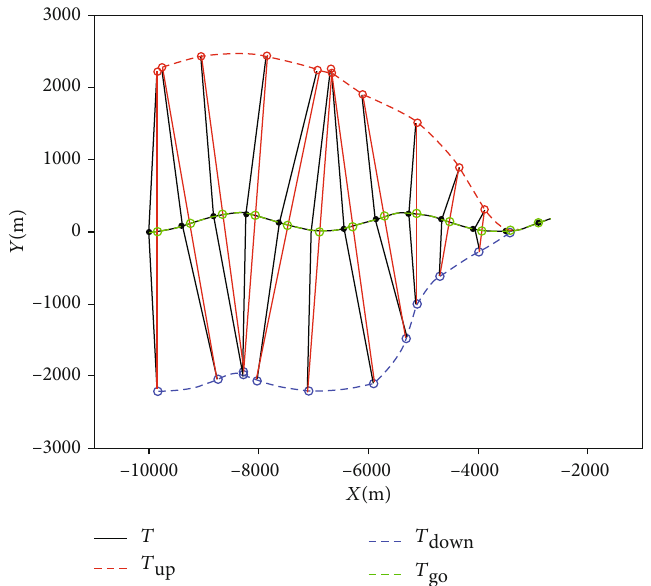
Figure 8: Real and virtual targets with high